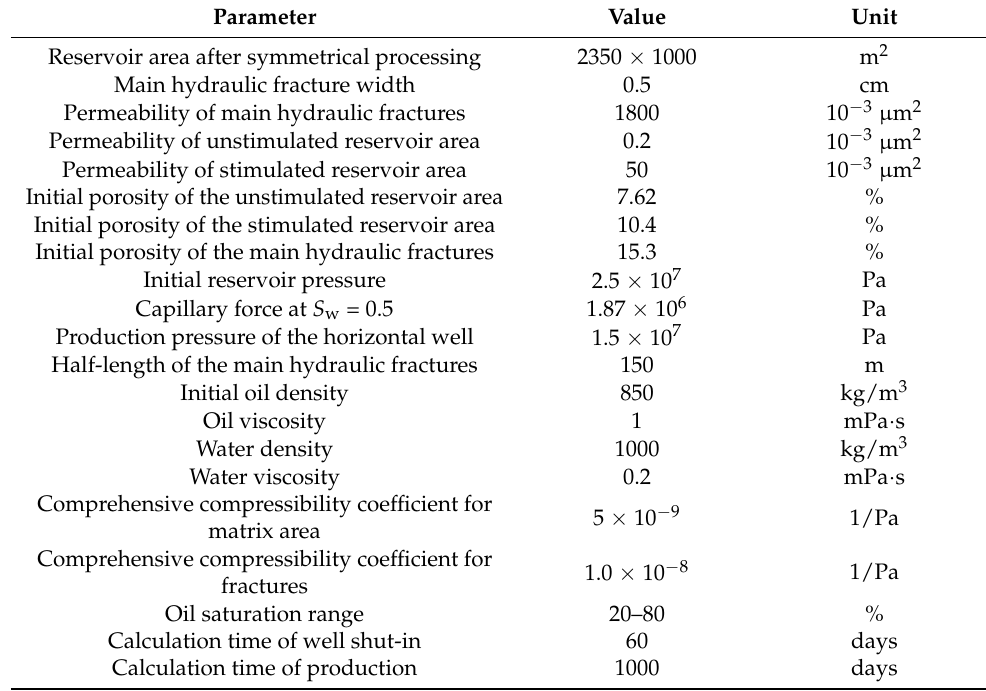
Table 2. Parameters for the simulation model of a multistage fracturing horizontal well in a shale oil reservoir.